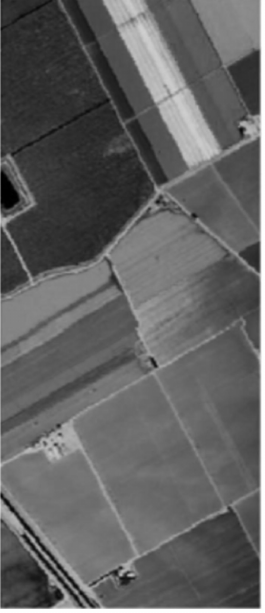
Figure 4. Sample band of the Salinas